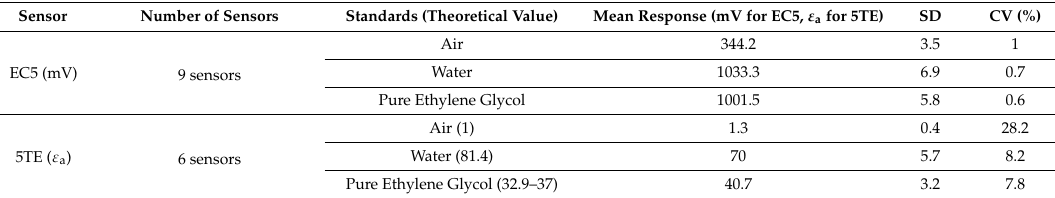
Table 4. Statistics of sensors response in air, water, and pure ethylene